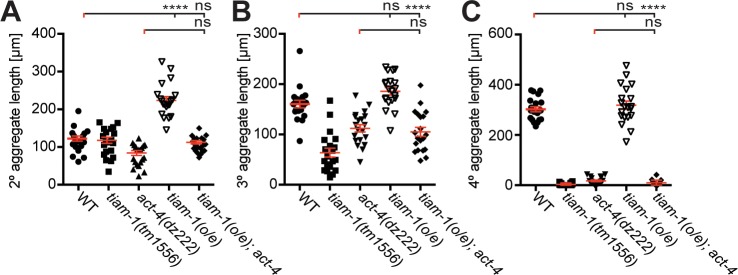
The tiam-1/GEF and act-4/Actin act downstream or in parallel of the dma-1/LRR-TM receptor in PVD dendrites.Quantification of the aggregate length of secondary, tertiary, and quaternary branches 100 µm anterior to the PVD cell body in the genotypes indicated. For raw data see Figure 1— source data 1. Statistical significance is indicated as Data are represented as mean ±SEM. Statistical comparisons were performed using one-sided ANOVA with the Tukey correction. Statistical significance is indicated (ns, not significant, **p<0.01, ***p<0.001, ****p<0.0001). n = 20 for all samples.